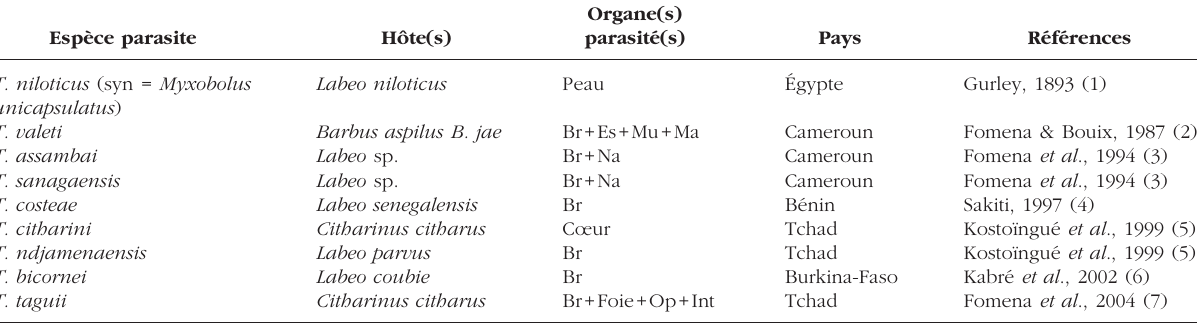
Tableau I. – Liste systématique des différentes espèces de Thelohanellus antérieurement décrites chez les Téléostéens d’eau douce d’Afrique.